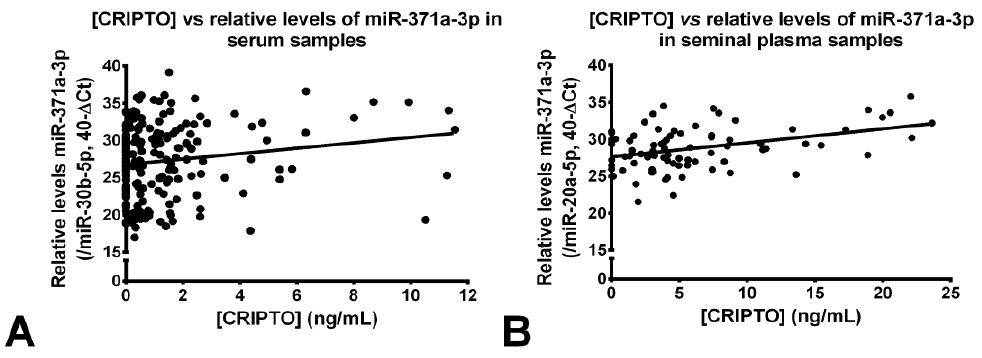
Figure 3. Correlation between CRIPTO concentration and miR-371a-3p relative levels in the serum samples ( A ) and in the seminal plasma samples ( B ). Relative levels of miR-371a-3p were normalized with miR-30b-5p (serum) and miR-20a-5p (seminal plasma) and plotted in the 40-ΔCt format.